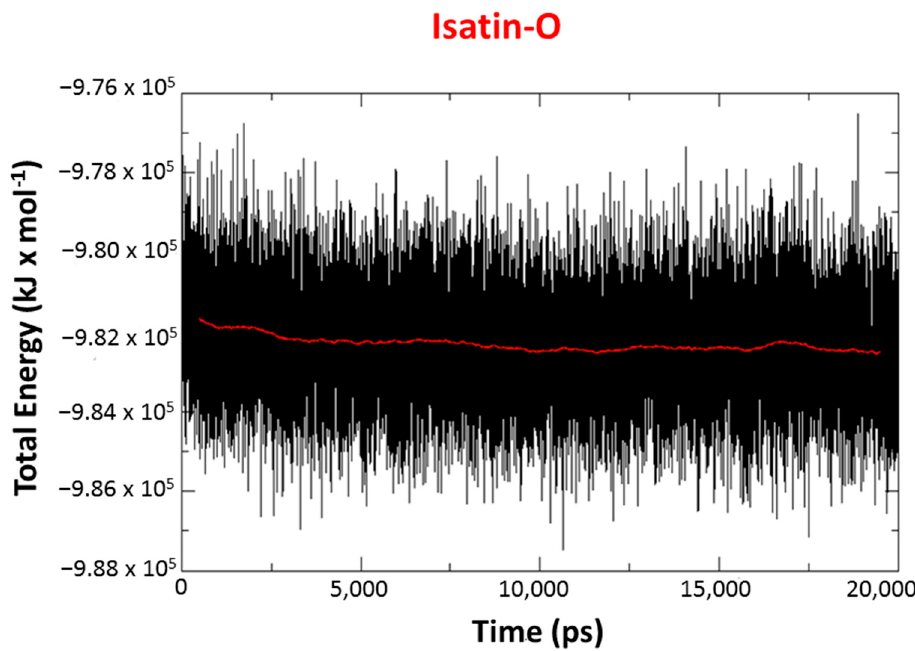
Figure 8. Energy plot for the complex Ee AChE/POX/isatin-O during 20 ns of MD simulation.